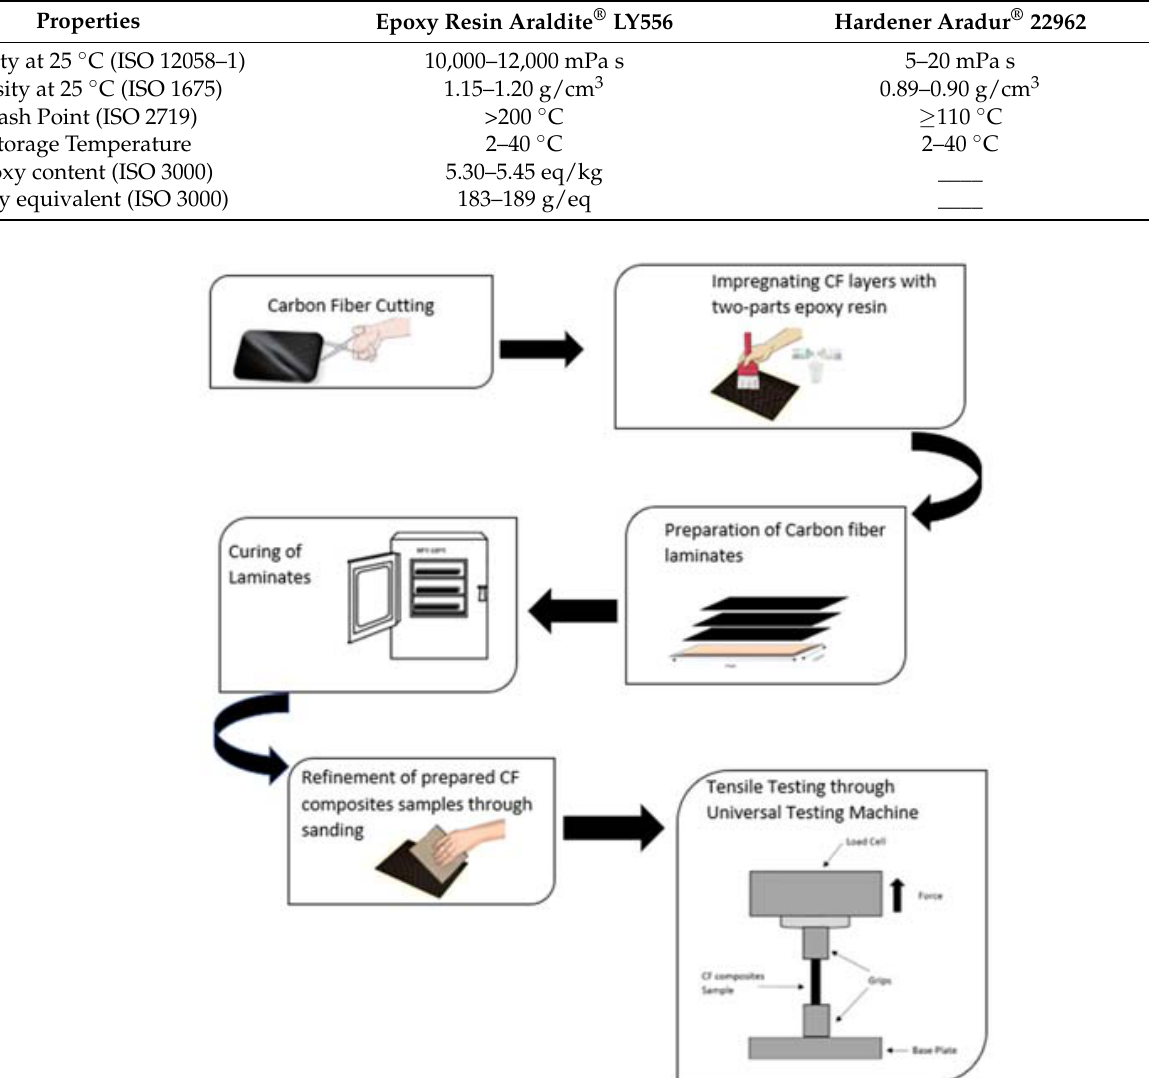
Figure 1. Hand Layup Process for producing carbon-fiber composite samples.